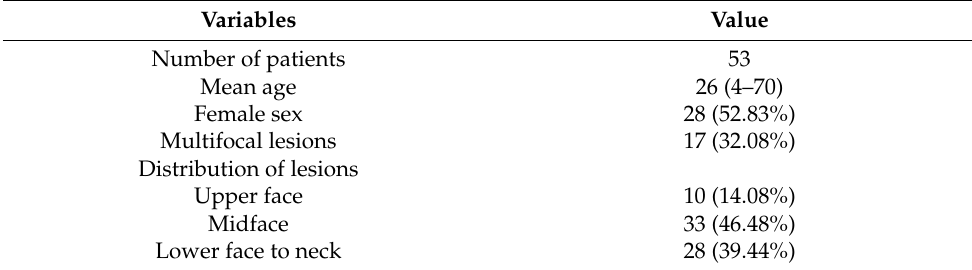
Table 1. Patient characteristics of the target dataset.